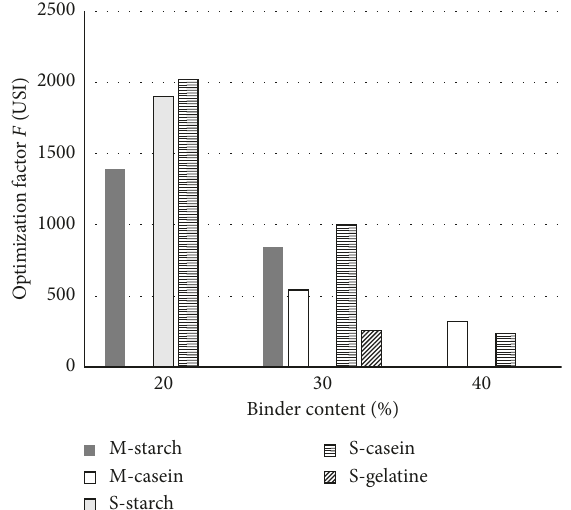
Figure 5: F performance of mechanically tested configurations.